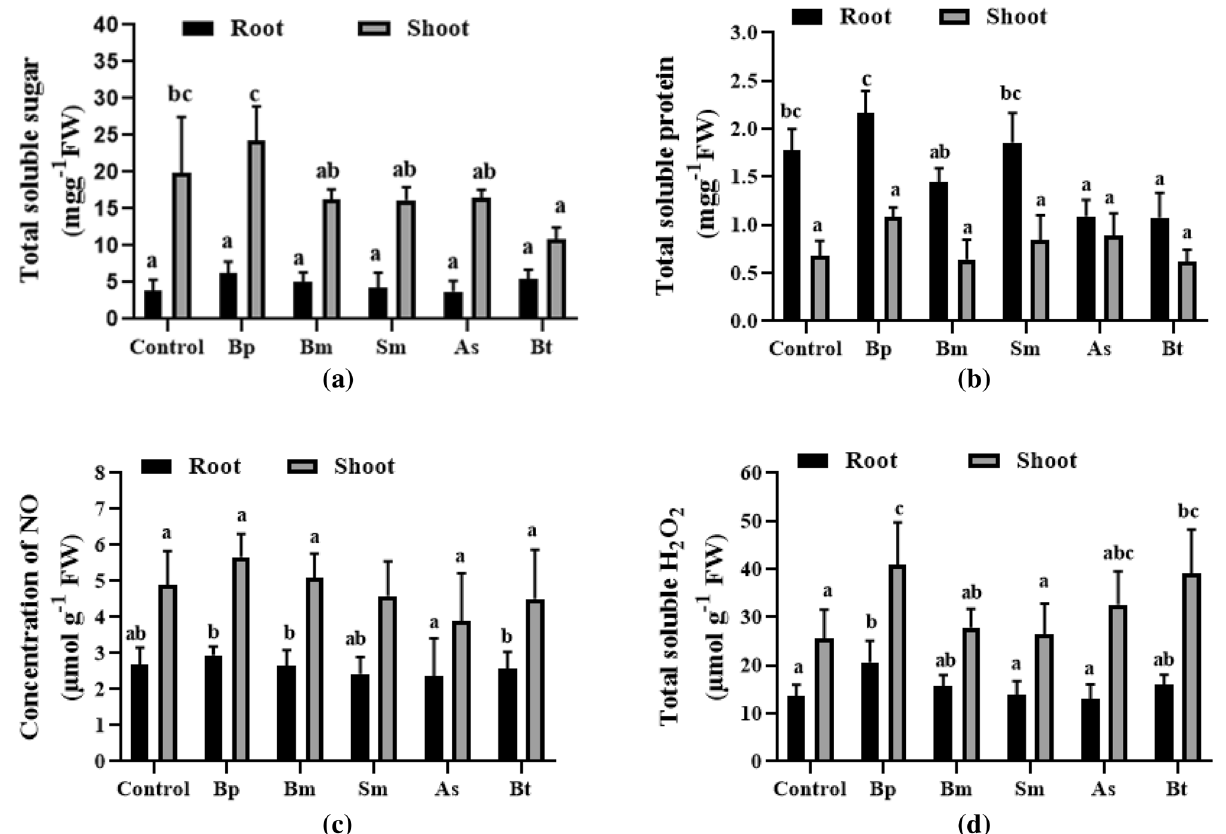
Figure 3. Biochemical characterization of wheat root and soot treated with five different bacterial strains. Here, ( a ), ( b ), ( c ), and ( d ) are indicating total soluble sugar, total soluble protein, NO concentration, and total soluble H 2 O 2, respectively in both root and shoot. Different letters indicate significant differences between mean ± SD of replications (n = 3) at a P < 0.05 significance